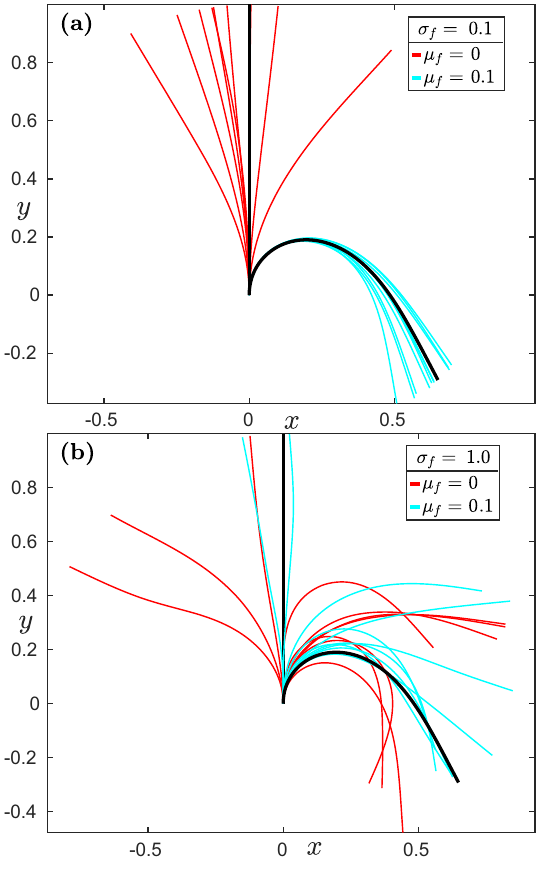
Figure 2. The influence of the noise magnitude on fiber configu- rations for 10 realizations (of a total of 200) for two fixed values of µ f . We show results for 2 di ff erent values of σ f : a) σ f = 0 . 1, b) σ f = 1 . 0. In both figures the black curve corresponds to the configuration obtained for the homogeneous distribution of forces, i.e. , σ f = 0.